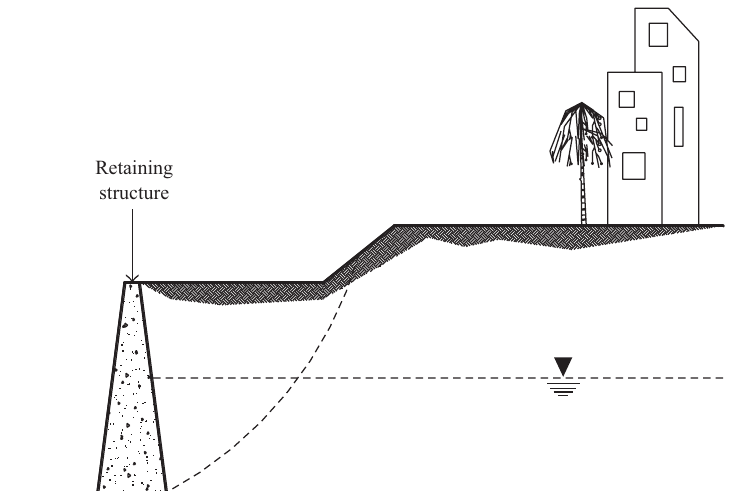
Figure 1: Application of retaining walls in civil engineering.